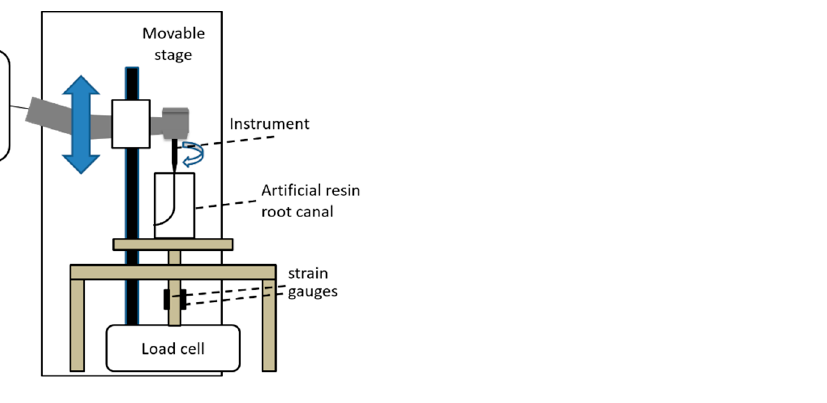
Figure 3. Schematic drawing of the automated root canal instrumentation device and the torque and vertical force measuring system used in the experiment.